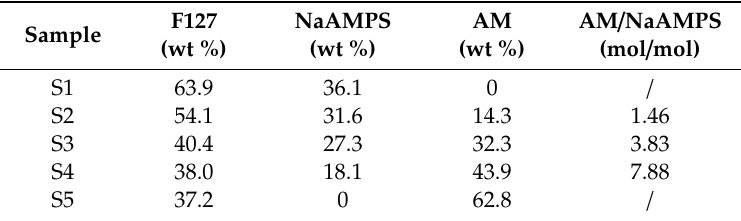
Table 2. Weight fraction of monomers in polymer and molar ratio of AM / NaAMPS for the five prepared